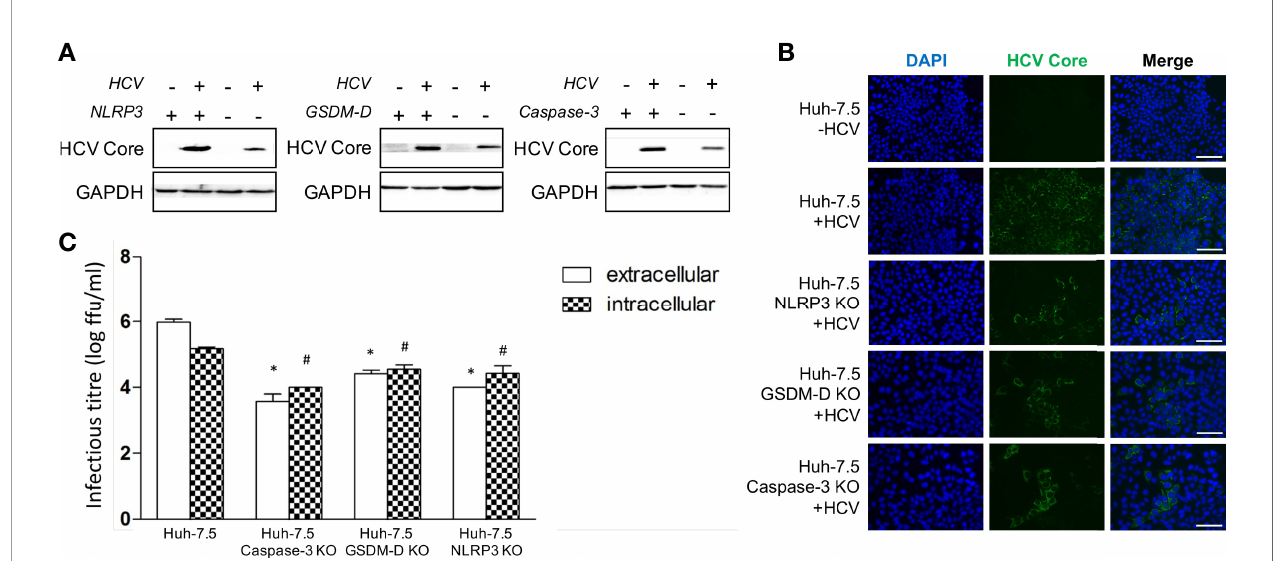
FIGURE 6 | Apoptosis and pyroptosis involvement in HCV spread. Huh-7.5 cells or Huh-7.5 KO cells (NLRP3 or GSDM-D or caspase-3) were infected with HCV at MOI = 1 or left uninfected and allowed to propagate for 3 days following infection. (A) Cells were harvested for Western Blot analysis and membranes were probed for HCV core protein and GAPDH. (B) Cells were fi xed using acetone and subsequently stained using an antibody speci fi c for HCV core protein (green) and nuclei were stained with DAPI (blue) for analysis by fl uorescence microscopy. Scale bar, 100 m m (C) Cells and cell culture fl uids were harvested for determination of intra- and extracellular titres, respectively. Titre was determined using limiting dilution assay. * indicates p < 0.05 for differences in extracellular titre, # indicates p < 0.05 for differences in intracellular titre. (A – C) Data are representative of three independent experiments.